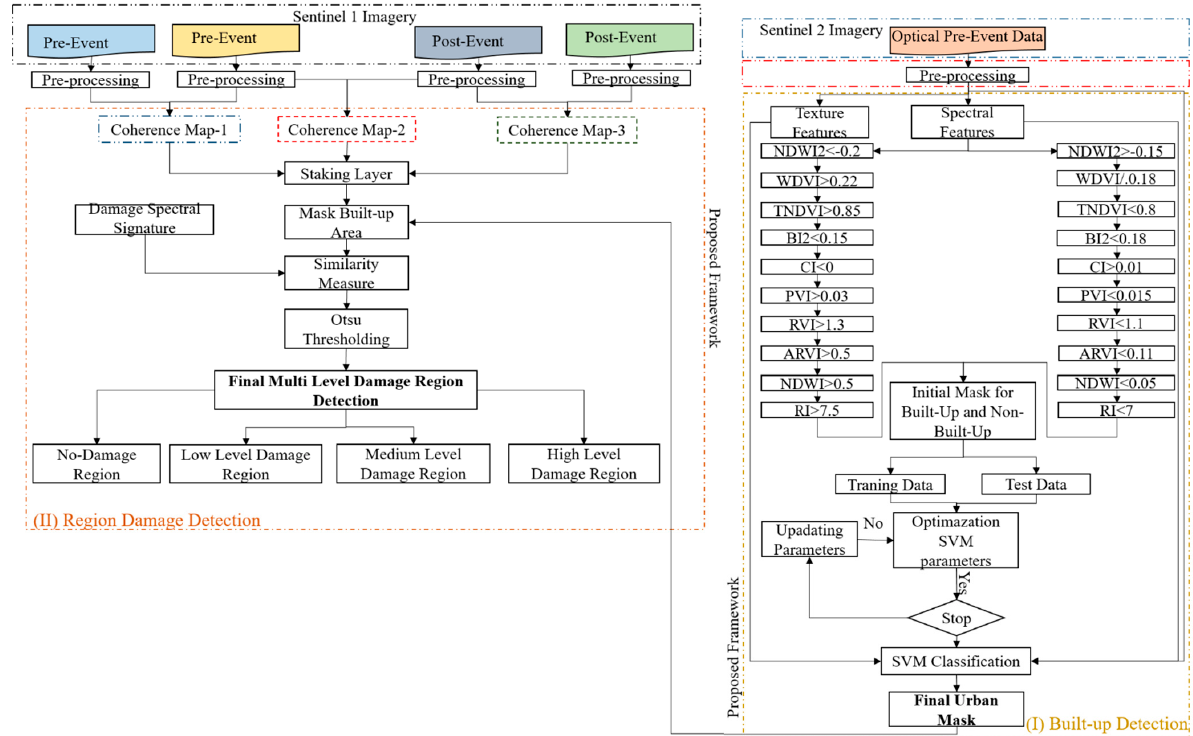
Figure 4. An overview of the proposed method in three steps.